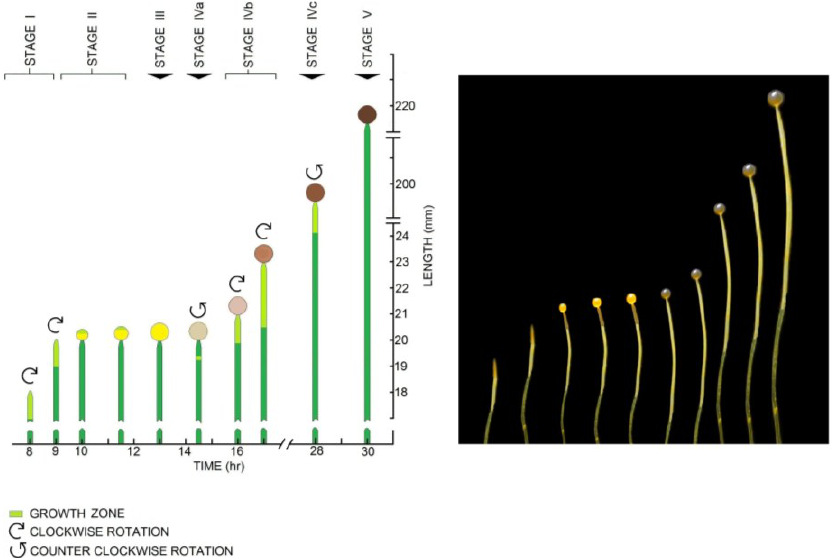
Figure 1. The schematic illustration ( left ) and corresponding photograph ( right ) show the developmental stages of the sporangiophore of P. blakesleeanus . Sporangiophore development is divided into five stages (Stages I, II, III, IV and V), and Stage IV is further divided into three sub-stages (IVa, IVb and IVc). The sporangiophores exhibit expansive growth and irreversible wall deformation in a region termed the “growth zone”. The growth zone is located at the apical tip (tip growth) in Stage I and Stage II and adjacent to the sporangium (intercalary growth) in Stage IV. The Stage I sporangiophore is a single pointed cell that grows longitudinally at the apical tip in the growth zone, 1–2 mm in length. In the schematic, the growth zone is shown as light green and the non-growing stalk is dark green. Clockwise rotation (when viewed from above) and elongation growth occur concurrently during Stage I, producing left-handed helical